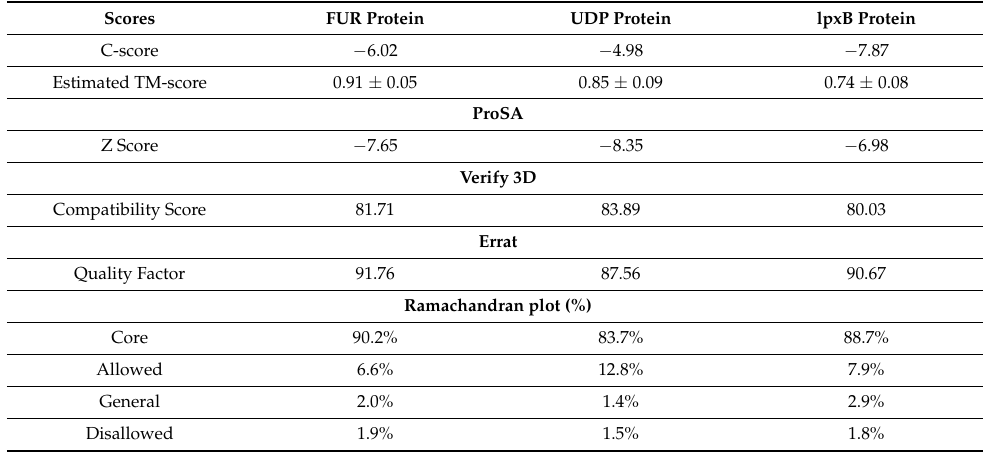
Figure 1. 3D structures of drug targets predicted by I-Tasser. Table 2. Structural validation of target